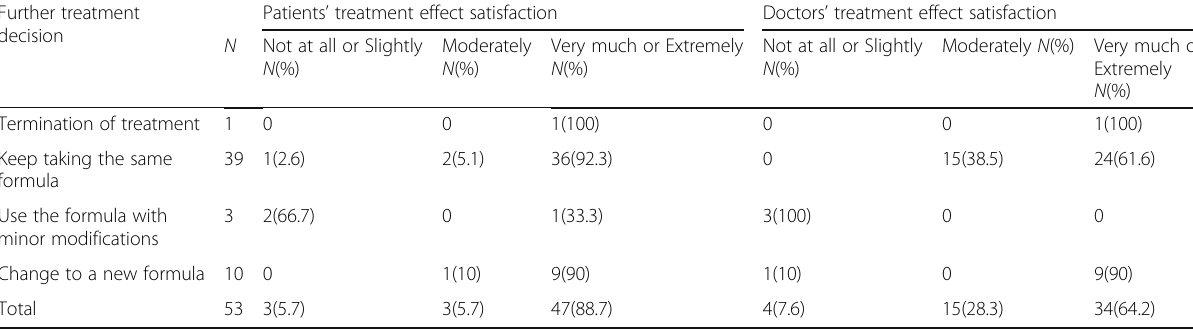
Table 6 Comparison of Patients ’ and Doctors ’ Treatment Effect Satisfaction with Doctors ’ Follow-up Decisions Further treatment